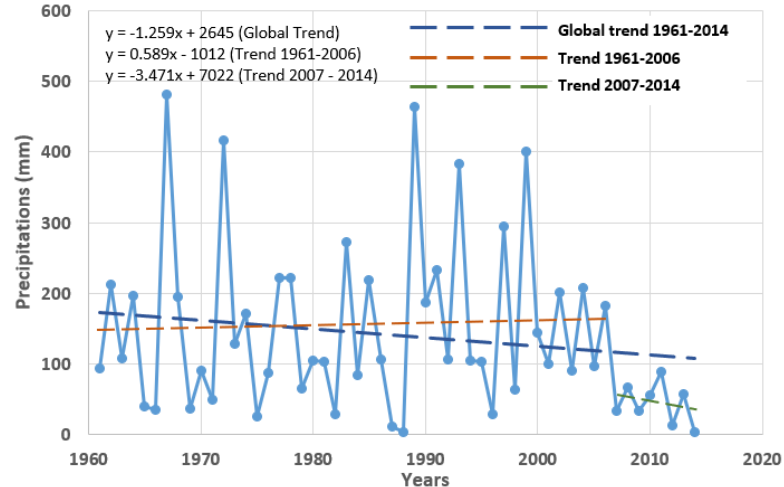
Figure 4. Annual precipitation and adjusted linear models over the whole period (1961 – 2014) and two sub-periods, 1961 – 2006 and 2007 – 2014 (Djibouti International Airport Station). Table 3. Descriptive statistics of the series of annual precipitation values. SD: Standard Deviation, CV: Coefficient of Variation, CA: Coefficient of Asymmetry.